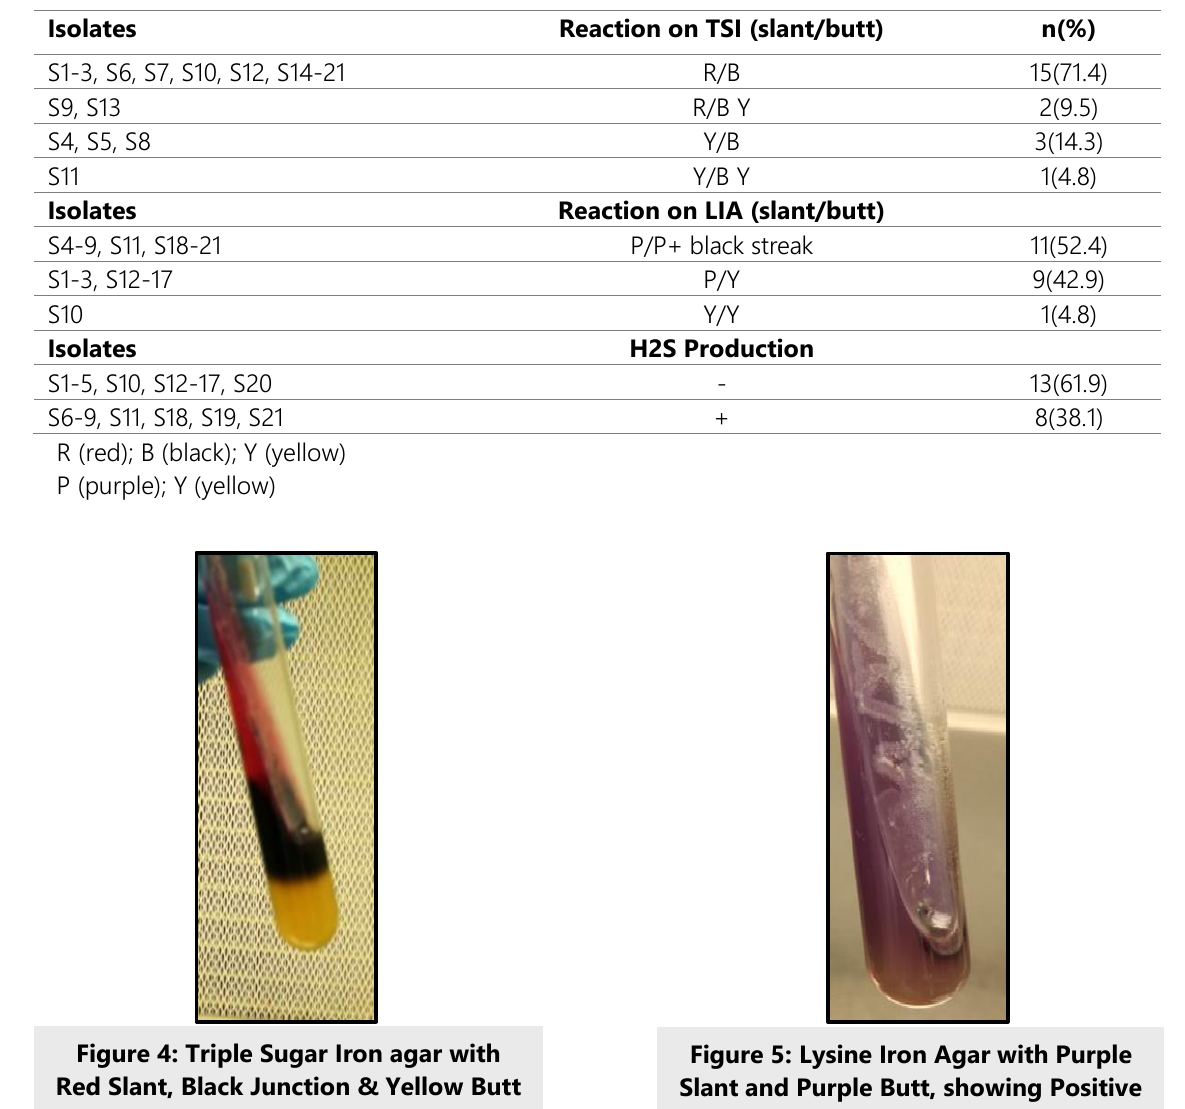
Figure 1: Enlarged Separated Colonies of Salmonella on HE Agar